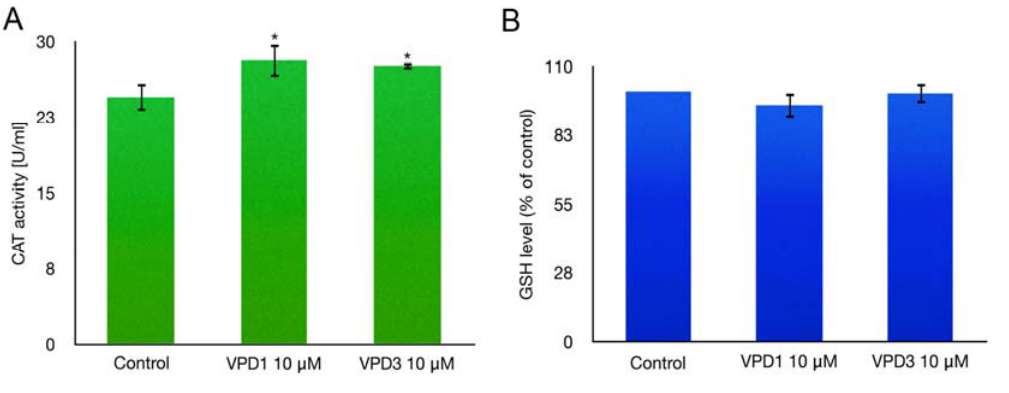
Figure 8. Catalase (CAT) activity ( A ) and level of reduced glutathione (GSH) ( B ) in mHippoE-18 cells after 24 h exposure to 10 μ M of VPDs.